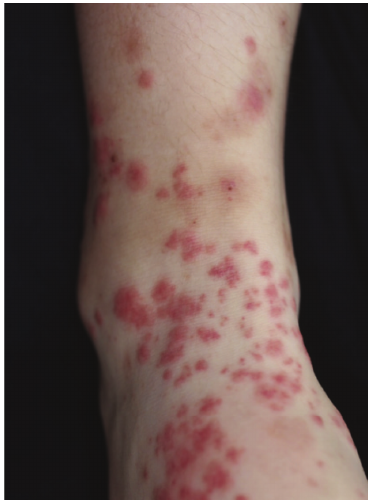
Figure 2: Skin lesions noted in the patient. The patient had edematous erythema and erythema-nodosum-like eruptions on the lower